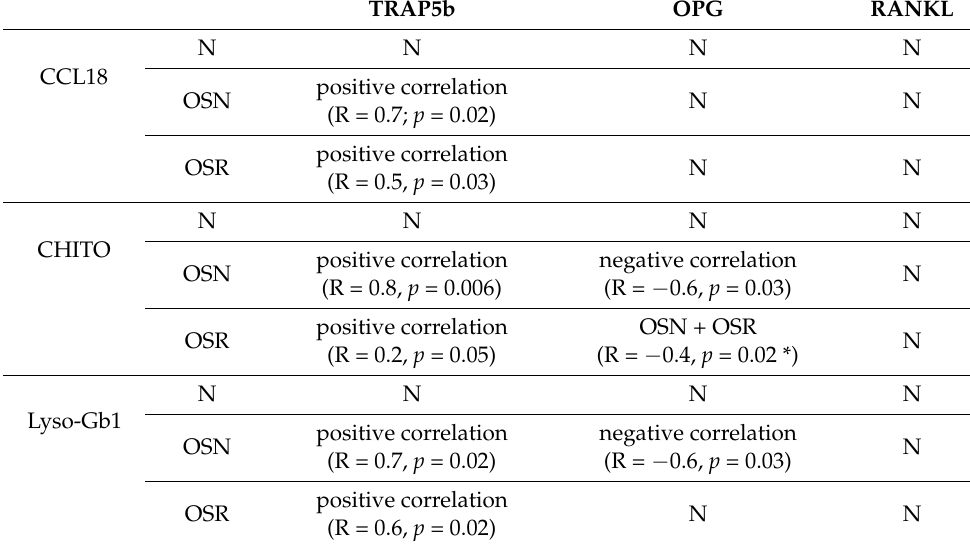
Figure 7. TRAP5b, RANKL, OPG correlation with biomarkers: CCL18, lyso-Gb1, and chitotriosidase in all GD patients. Scatterplot analysis of correlation of TRAP5b and CCL18 ( A ), TRAP5b and lyso-Gb1 ( B ), TRAP5b and chitotriosidase ( C ), RANKL and CCL18 ( D ), RANKL and lyso-Gb1 ( E ), RANKL and chitotriosidase ( F ), OPG and CCL18 ( G ), OPG and lyso-Gb1 ( H ), and OPG and chitotriosidase ( I ). p -values: statistical comparison was determined via Pearson’s two tail linear regression correlation analysis. Table 2. TRAP5b, RANKL, OPG correlation with CCL18, lyso-Gb1, and chitotriosidase (CHITO) in N, OSN, and OSR cohorts. Statistical comparisons were determined via Pearson’s one tail linear correlation analysis. * Statistical analysis included GD patients with abnormal bone density (OSN and OSR), two OSR outliers were removed.